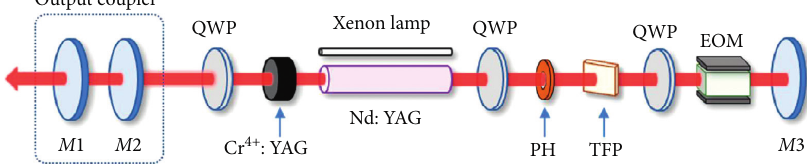
Figure 22: Schematic of dual Q-switched SLM laser [82]. Table 1: Comparison of advantages and disadvantages of typical SLM selection